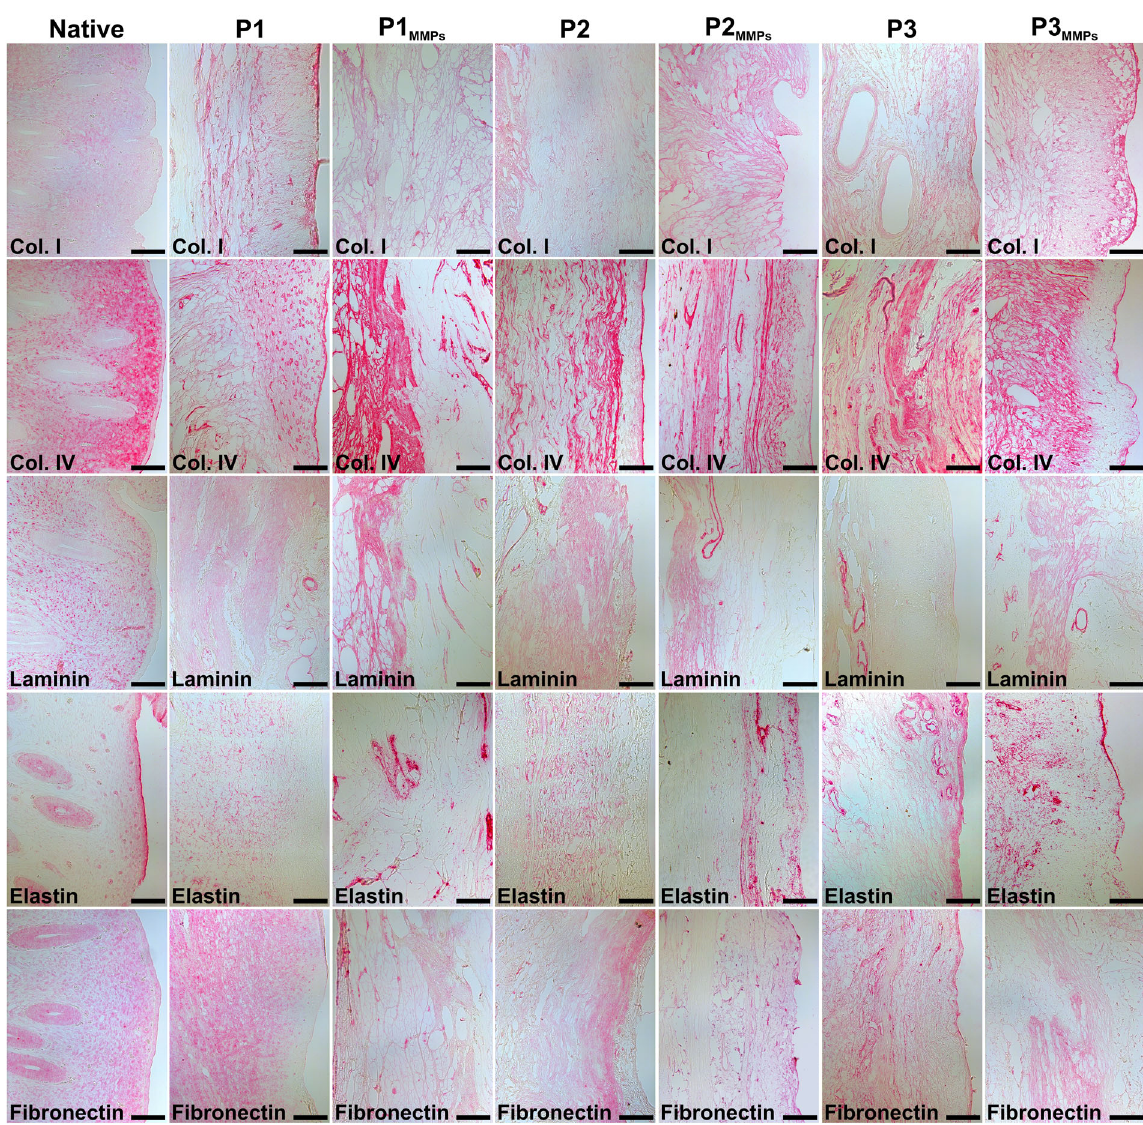
Fig. 3 Distribution of importantant structural components after scaffold production. Immunohistochemistry stained sections from decellularized sheep uterus tissue before and after matrix metalloproteinase 2 and 9 (MMPs) preconditioning, including native uterus tissue for comparison. P protocol, Col. collagen. Scale bars = 100